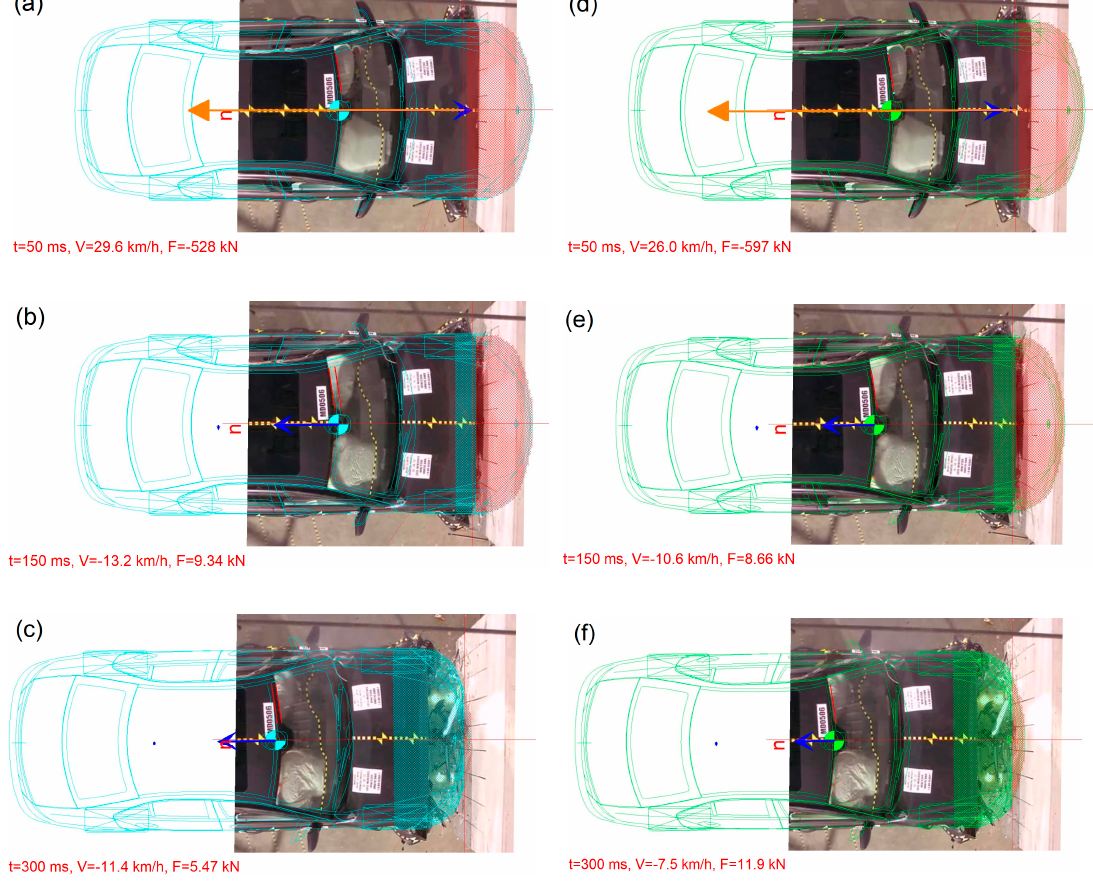
Figure 8. Comparison of car projections with recorded images for default data: t = 50 ms ( a ), t = 150 ms ( b ), t = 300 ms ( c ) and identified data: t = 50 ms ( d ), t = 150 ms ( e ), and t = 300 ms ( f ).